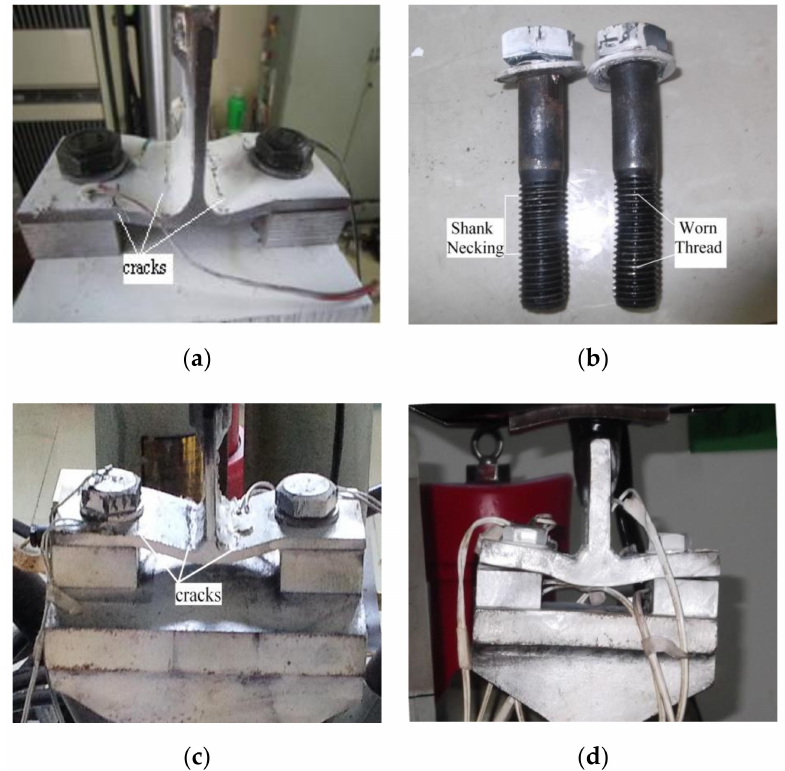
Figure 6. Failure modes of three specimens from di ff erent groups under compressive loads: